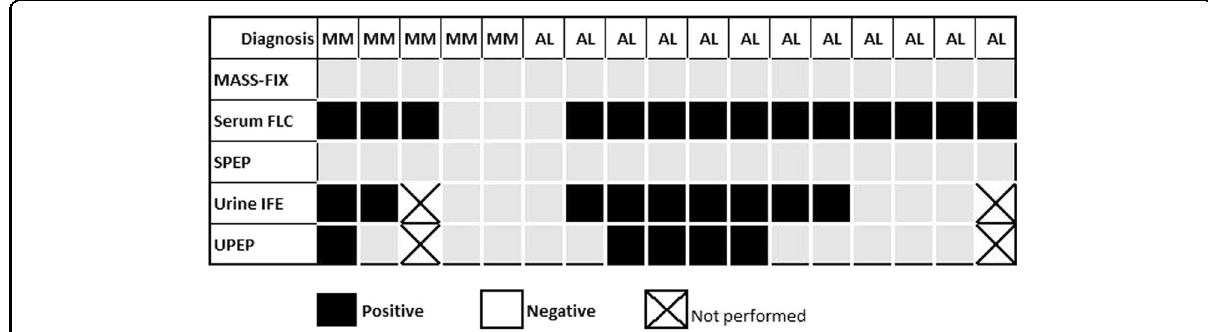
Fig. 3 Serum and urine monoclonal protein study performance for untreated, MASS-FIX negative multiple myeloma and AL amyloidosis patients. Columns represent individual patients; FLC, free light chains; SPEP, serum protein electrophoresis; IFE, immuno fi xation; UPEP, urine protein